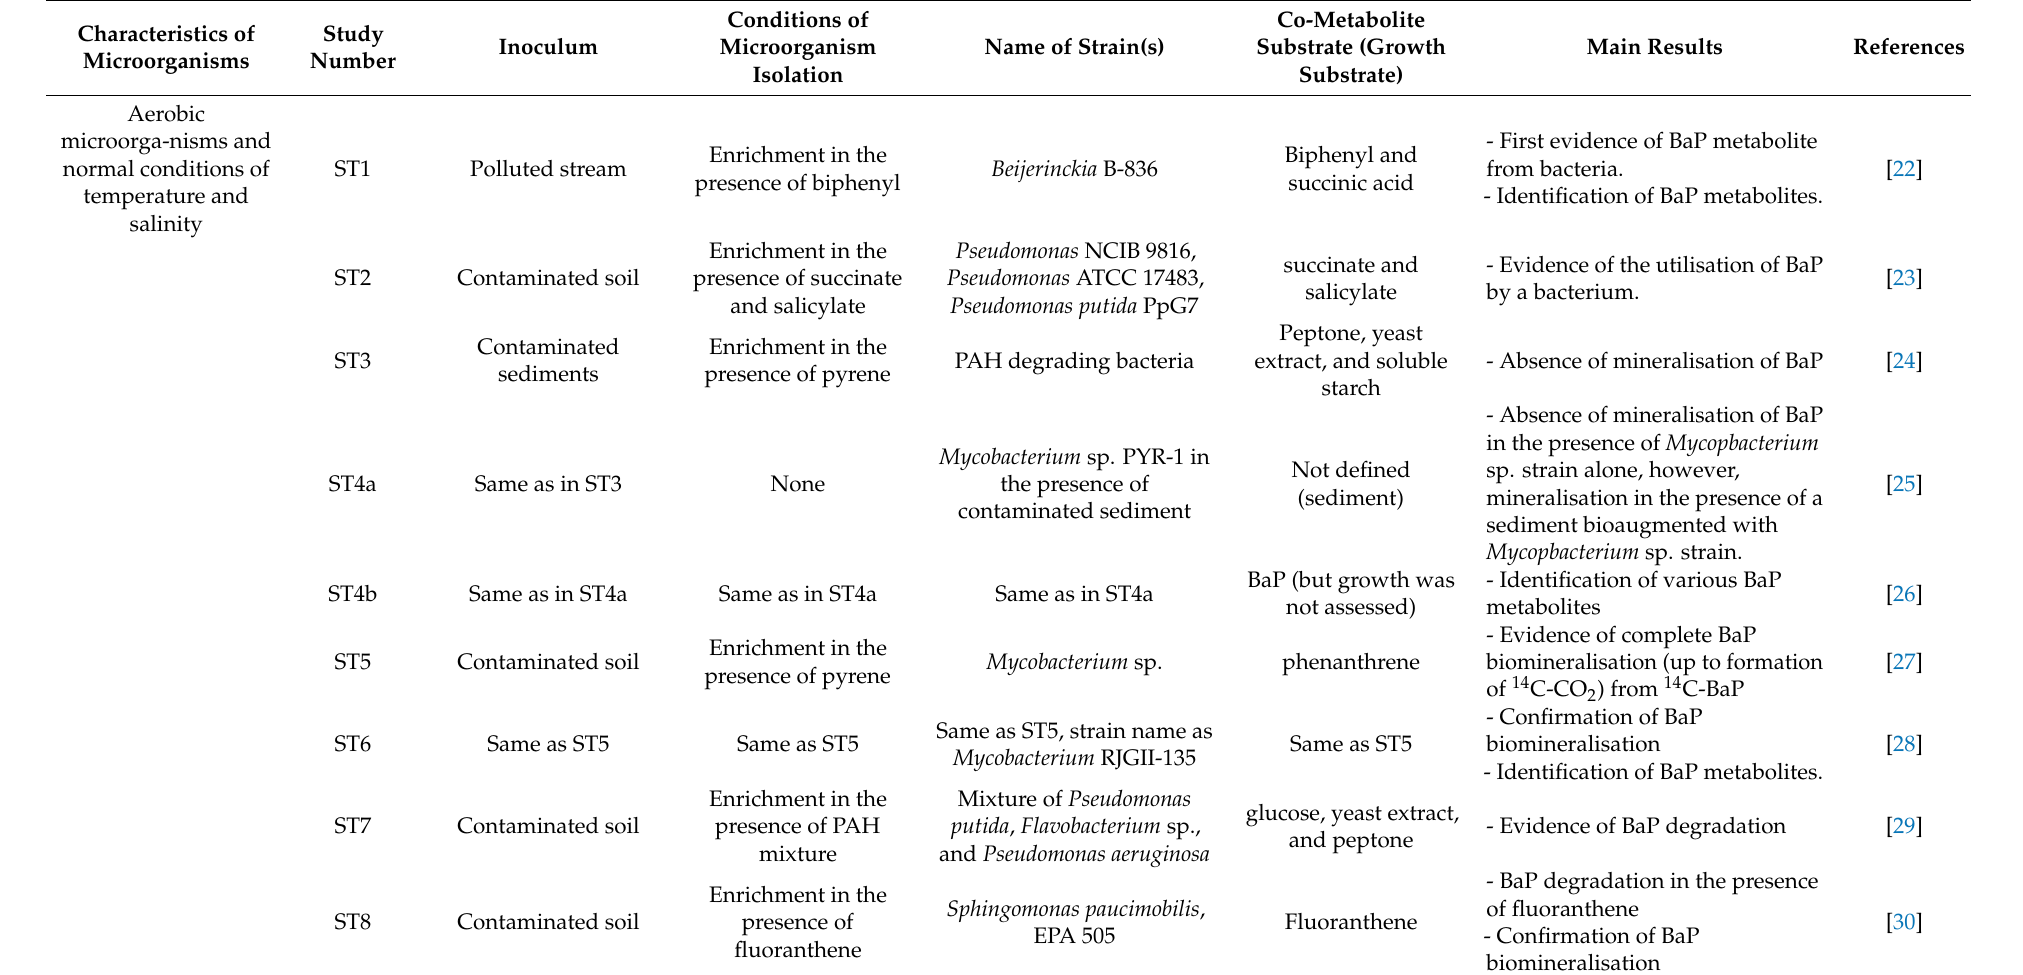
Table 1. Summary of studies on the degradation of benzo(a)pyrene (BaP) by